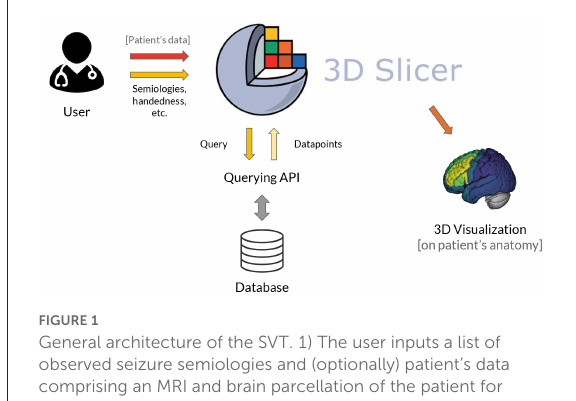
FIGURE1 General architecture of the SVT. 1) The user inputs a list of observed seizure semiologies and (optionally) patient’s data comprising an MRI and brain parcellation of the patient for visualization in the patient’s space. 2) The GUI of the 3D Slicer module is used to input the observed semiologies to the software, without the need to code. 3) The 3D Slicer module generates a structured query that is sent to be processed by the querying API to access the database. 4) The database is queried and the retrieved datapoints are converted into a 3DMMI visualization showing the EZ probability map overlaid to the patient’s anatomy, if